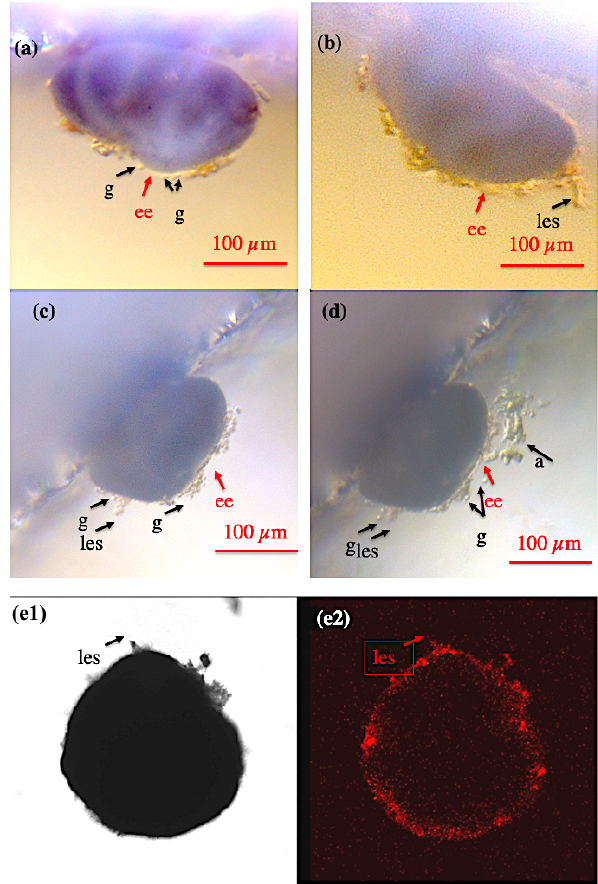
Figure 1. Shell envelope I. (a–b) Shell envelope (ee) of a Cibi- cidoides pachyderma specimen revealing multiple granule (g) and initial static ectoplasmic structures (les). (c–d) Shell envelope of a C. pachyderma specimen 24h before (c) and during feeding (d) . During feeding multiple mobile granule and attached algae (a) in- dicate a pseudopodial network presumably originating in the shell envelope. (e-1–e-2) BCECF-AM incubated C. lobatulus specimen viewed under normal transmitted light (e-1) and laser excitation ex- hibiting the BCECF-AM fluorescence (e-2) . As C. lobatulus speci- mens possess a thick shell, only the shell envelope, an initial lasting ectoplasmic structure (les), and especially granule reveal bright red fluorescence.